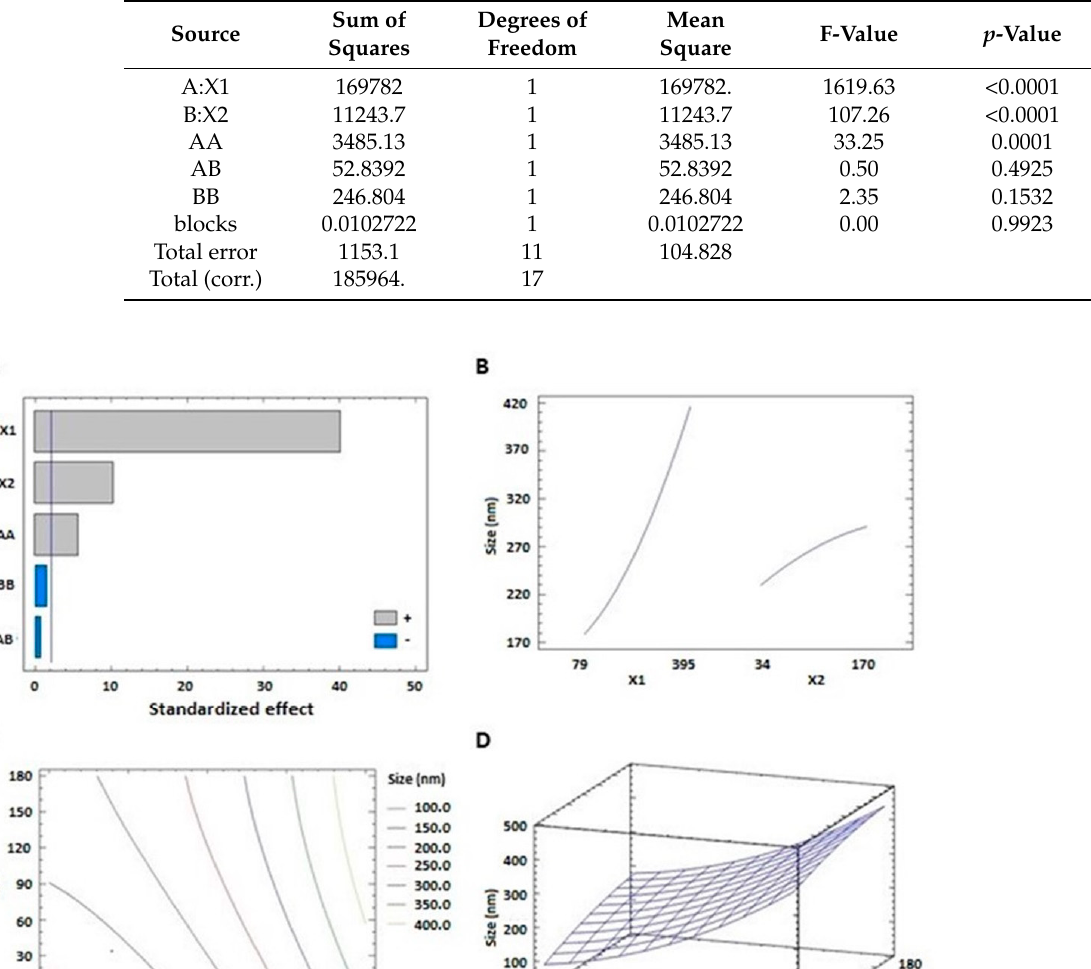
Table 4. Analysis of variance for the vesicle size of THQ–PL–SV phytosomes.